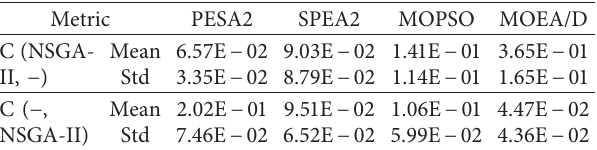
Table 4: Comparison results of